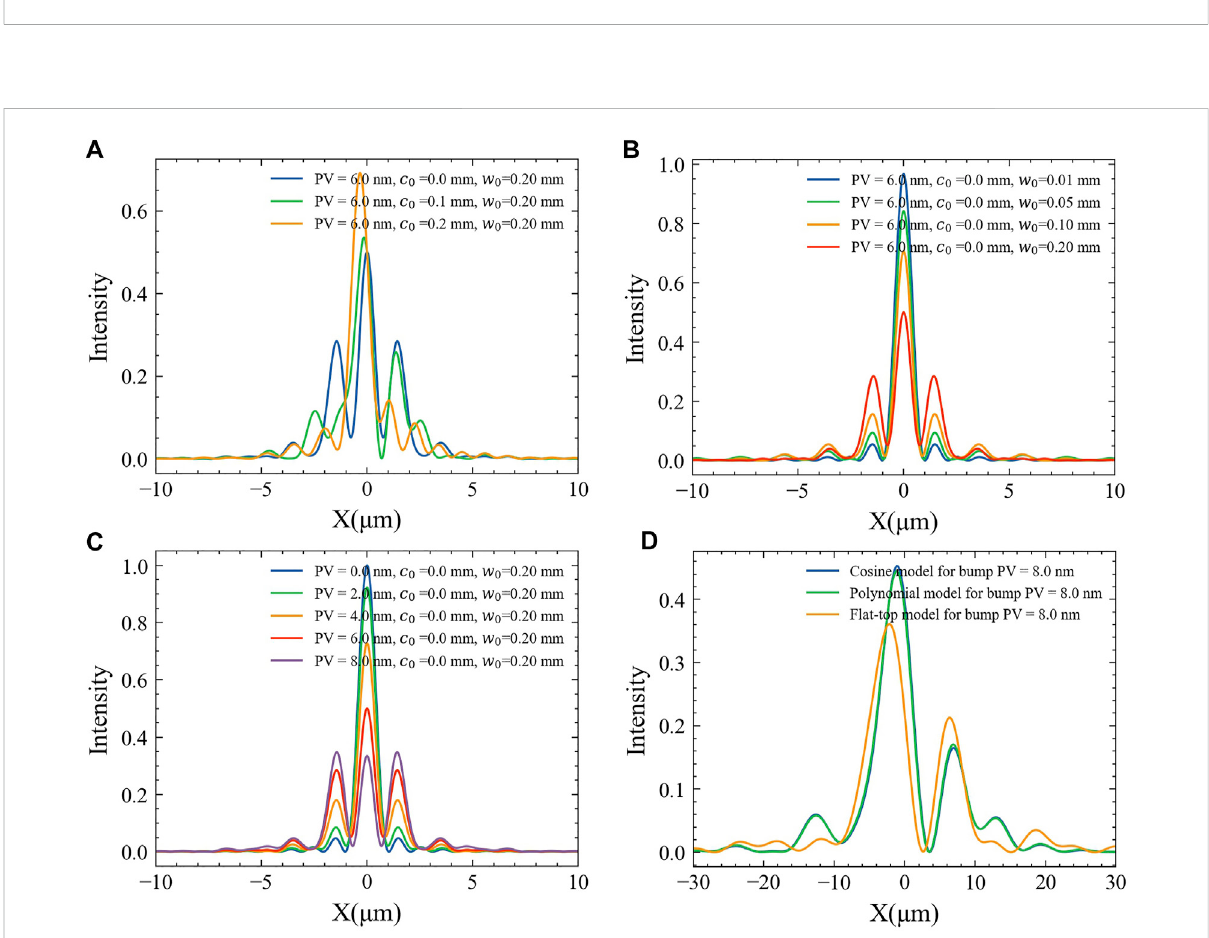
FIGURE 8 Veri fi cation of multi-segment decomposition approximation. (A) is shape fi t of segmented surface error. (B) gives focused spot pro fi le by different components and their interference.